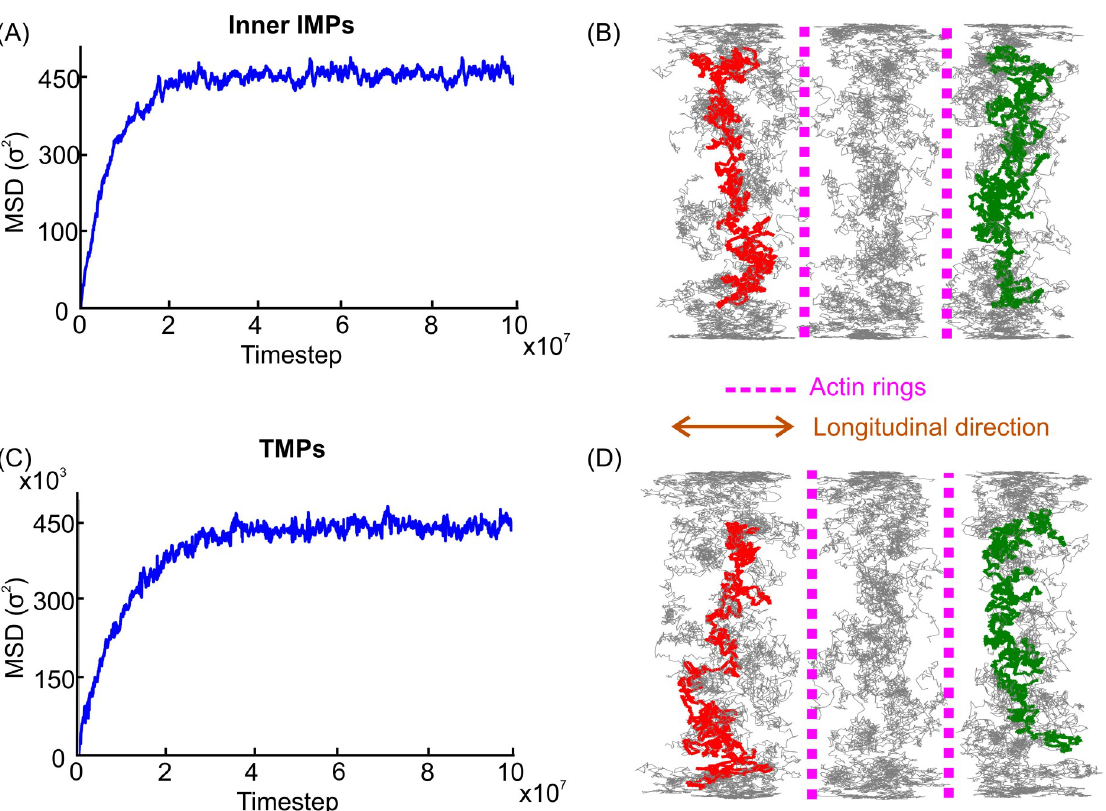
Fig 5. MSDs and trajectories of IMPs in the inner leaflet and TMPs. (A). Longitudinal MSD of IMPs in the inner leaflet. (B). Trajectories of IMPs in the inner leaflet. (C). Longitudinal MSD of TMPs. (D). Trajectories of TMPs.